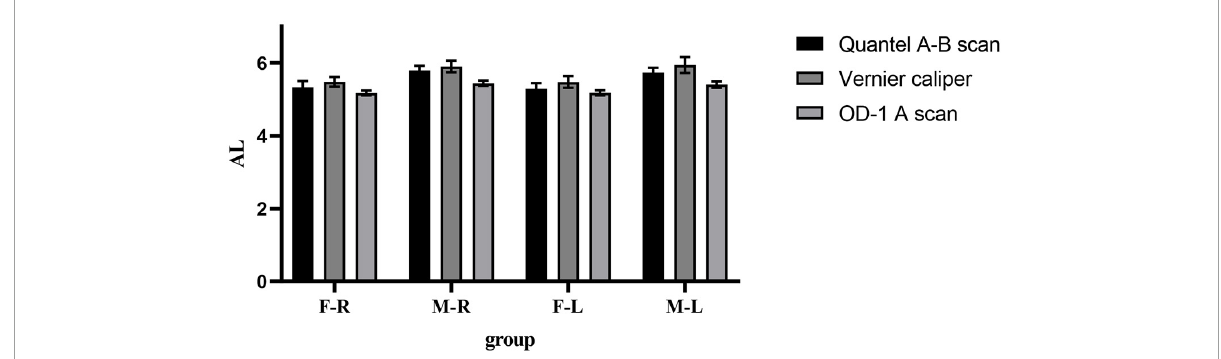
FIGURE1 Comparison results of the mean values of three AL measurement methods. F-R, female group right eye; M-R, male group right eye; F-L, female group left eye; M-L, male group left eye; AL, axial length.